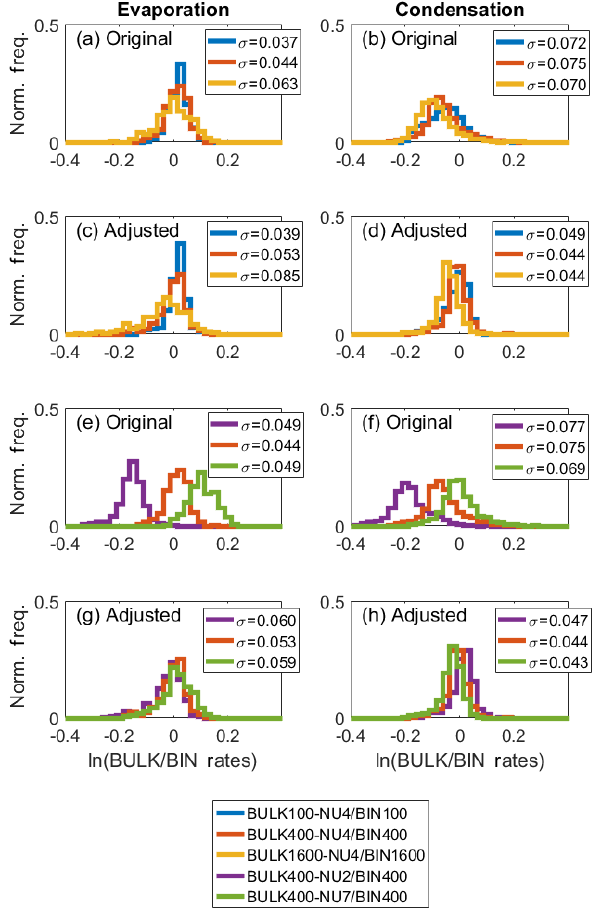
Figure 5. Like Fig. 3 but excluding grid points from the joint bins with relative humidity between 99.5 and